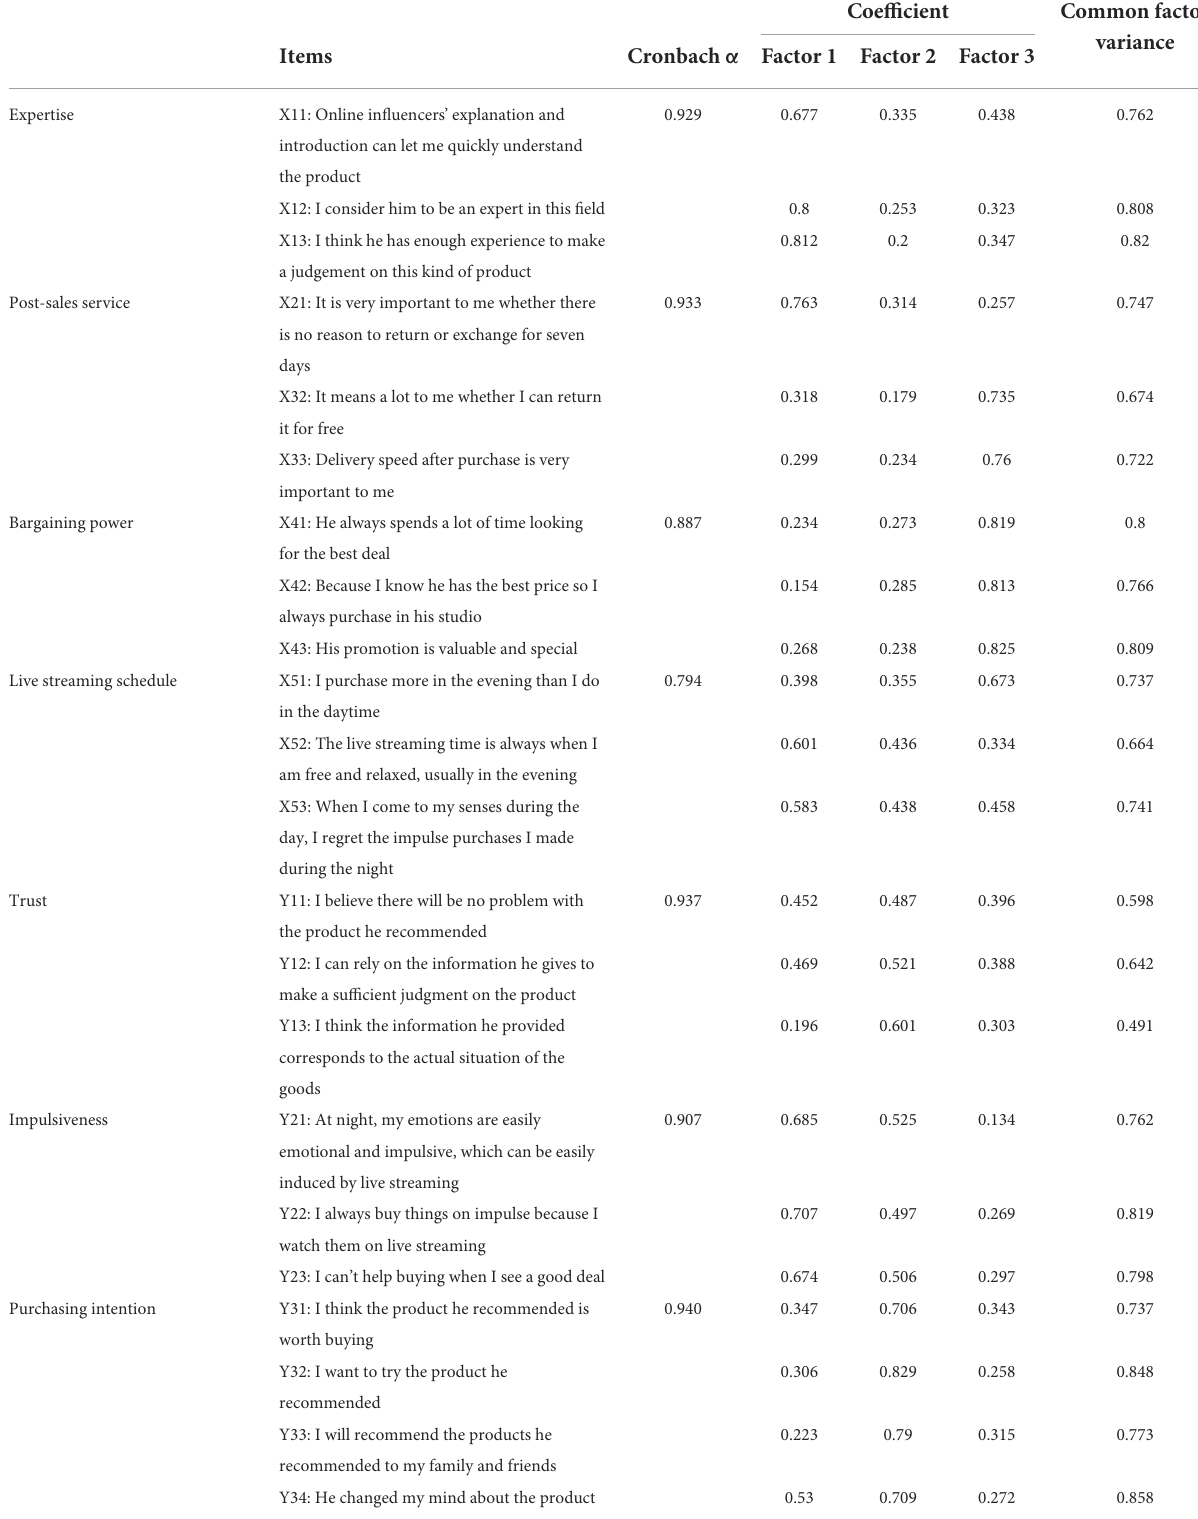
TABLE 1 Results of reliability and validity